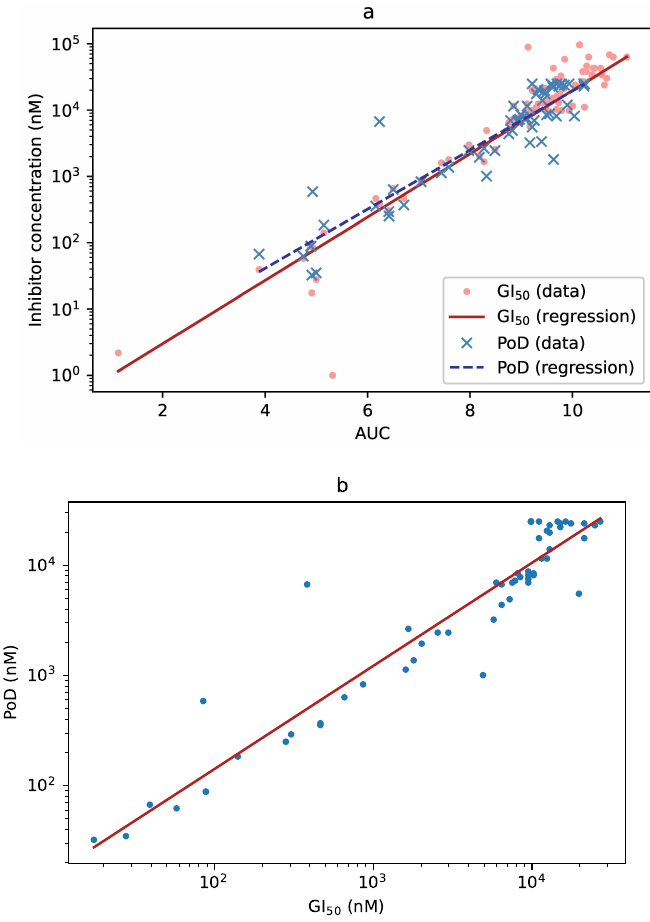
Figure 5. ( a ) Correlation between the AUC and GI 50 (dots, solid line) and between the AUC and PoD (crosses, dashed line). The three measures can be used more-or-less interchangeably for detecting substance effect. ( b ) Correlation between GI 50 and PoD. When both values could be computed (i.e., neither was infinite), they were very similar. Note, however, that PoD also depends on the experimental setup (see Discussion